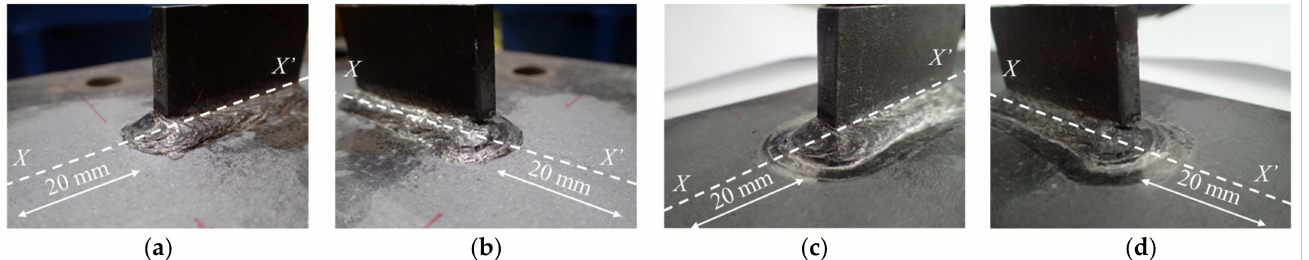
Figure 3. The bead profile: ( a ) Before hammer peening ( X ); ( b ) Before hammer peening ( X ’); ( c ) After hammer peening ( X ); ( d ) After hammer peening ( X